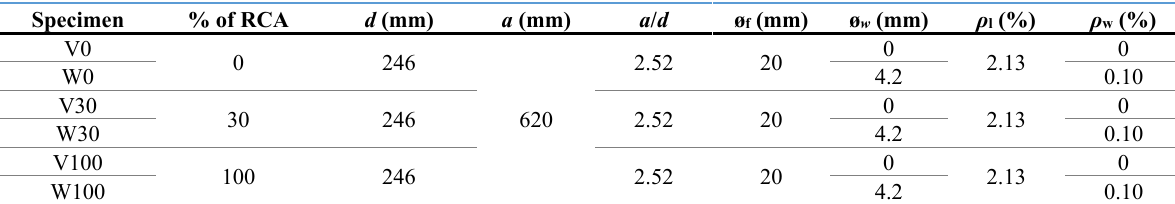
Table 1. Characteristics of the tested beams.